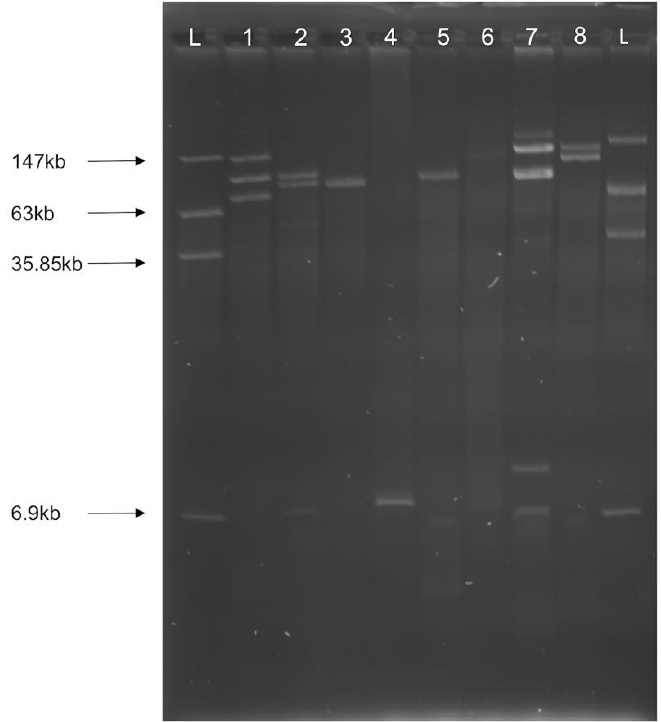
Figure 6. Plasmid profiles of representative AMR E. coli isolates. ( L ) Ladder E. coli 39R681; ( 1 ) IA- EC-0002; ( 2 ) IA-EC-0024; ( 3 ) IA-EC-0030; ( 4 ) IA-EC-0035; ( 5 ) IA-EC-0052; ( 6 ), IA-EC-0060; ( 7 ) IA- EC-0010; ( 8 ) IA-EC-0073. Plasmid size was approximated using GelAnalyzer software. ( 8 ) IA-EC-0073. Plasmid size was approximated using GelAnalyzer